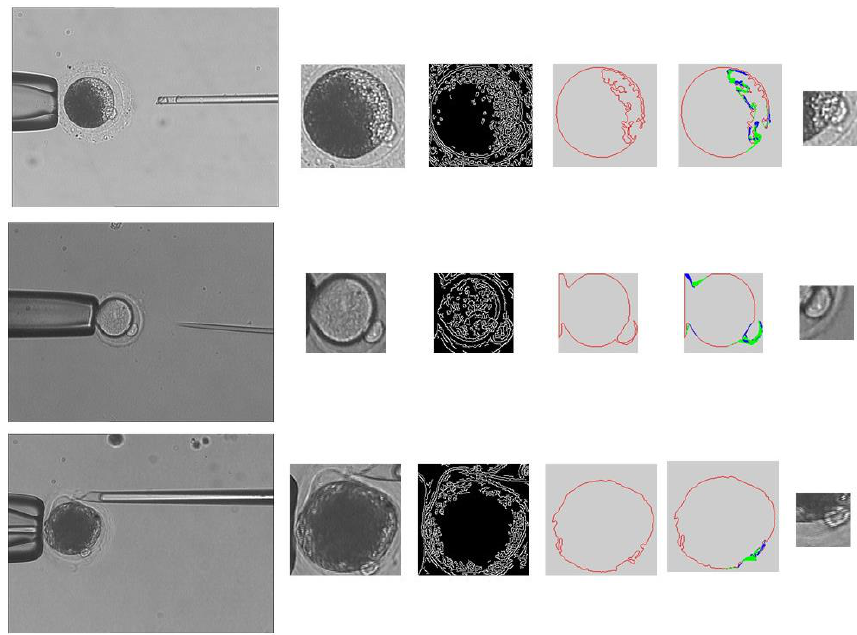
Figure 9. Detection results for various oocytes.